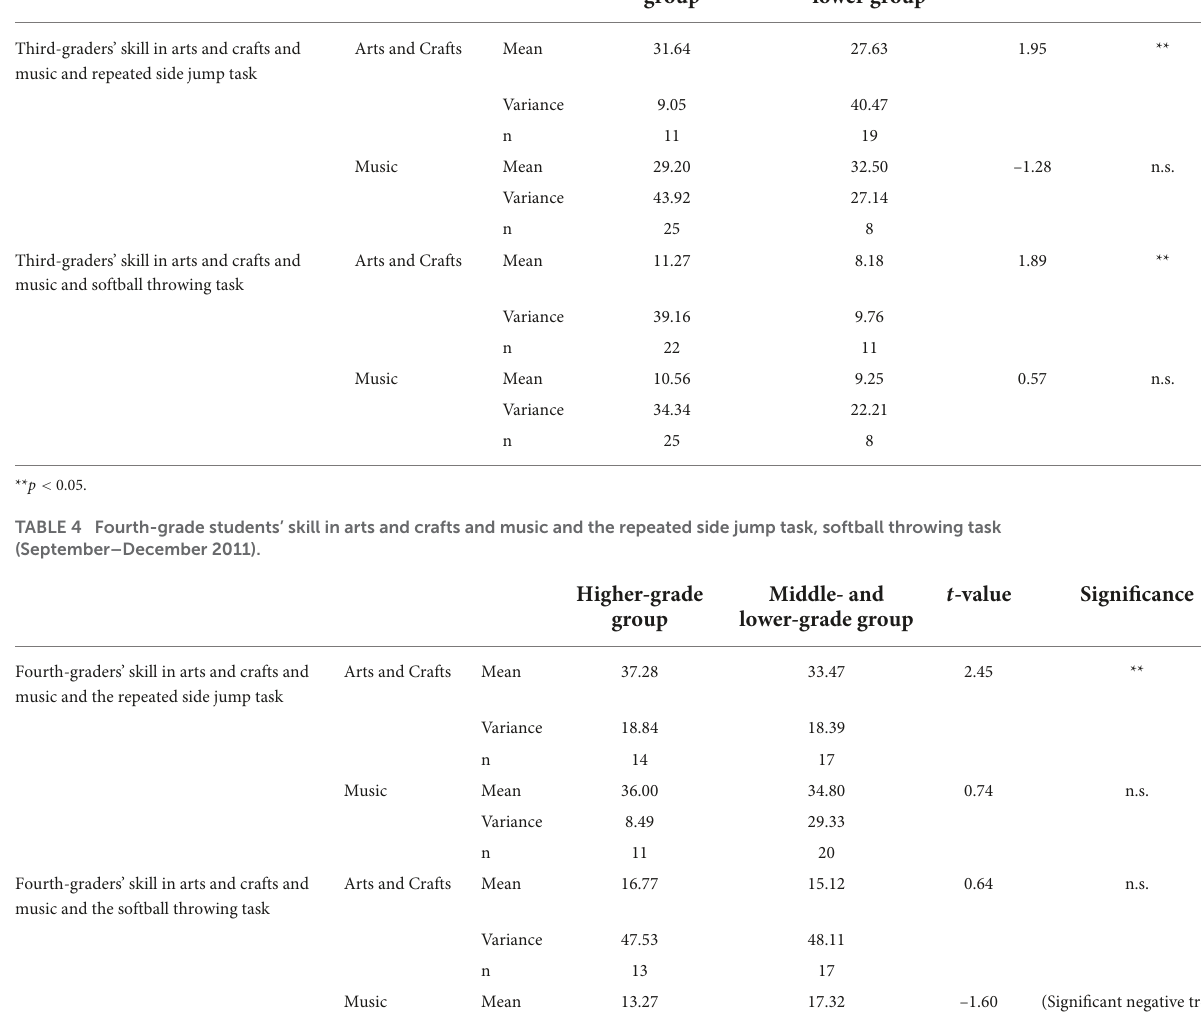
t -value Higher-grade Middle grade and group lower group